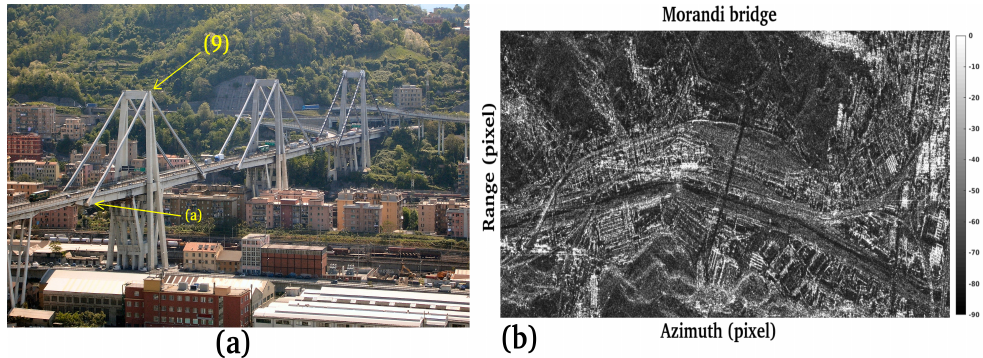
Figure 26. ( a ) Optical representation of the “Morandi” bridge, ( b ) SAR-SLC in magnitude of the “Morandi” bridge.